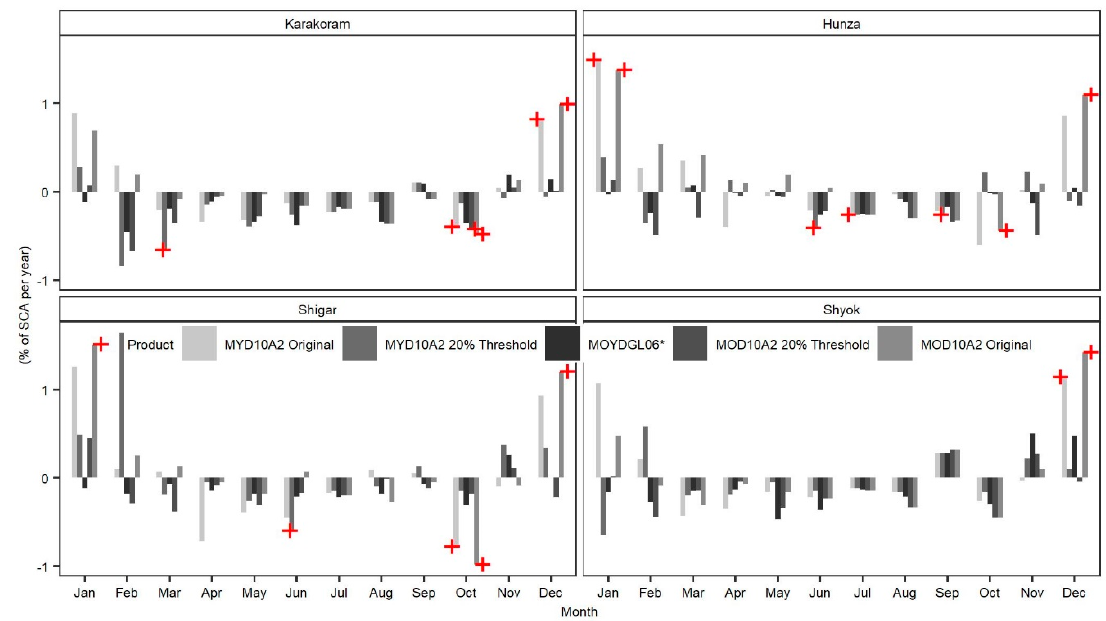
Figure 5. Monthly mean SCA trends in the Hunza, Shigar, Shyok, and Karakoram. Bars with plus signs represent statistically significant trends at the 90% confidence level.